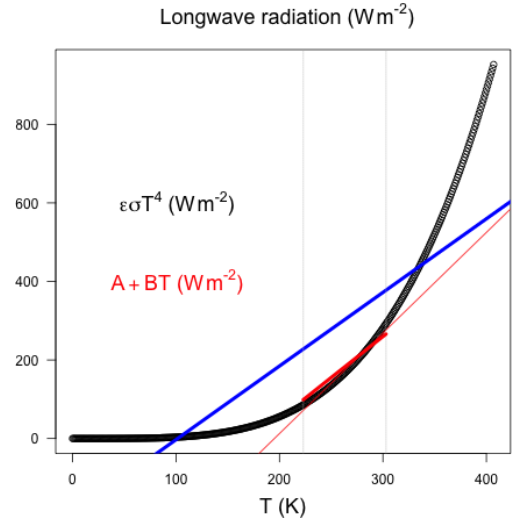
Figure A2. Black dots show (cid:15)σT 4 . The blue line shows the linear fit for the range of temperatures 0 to 407K. The thin red line shows the linear fit for temperatures between − 50 to 30 ◦ C (range is shown as vertical dotted lines). The thick red line shows Budyko’s (1969) linearization with A = 203 . 3Wm − 2 and B = 2 . 09Wm − 2 ◦ C − 1 . The regression coefficients for the blue line are A = 321 . 4Wm − 2 and B = 1 . 88Wm − 2 ◦ C − 1 , whereas for the thin red line they are A = 199 . 5Wm − 2 and B = 2 . 56Wm − 2 ◦ C − 1